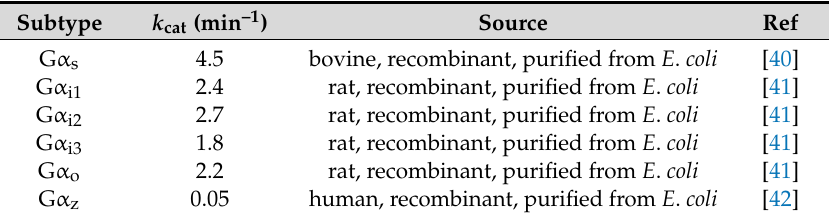
Table 1. k cat for GTP hydrolysis by G α